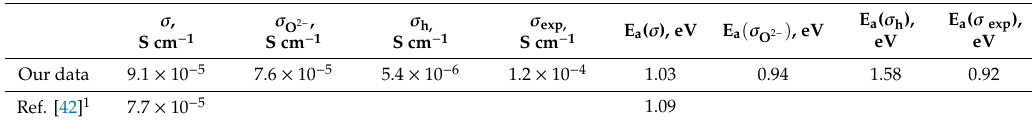
Table 1. The calculated values of the total, oxygen–ion and hole conductivity and the measured total conductivity of bulk SZY at 550 ◦ C in humid air ( p H 2 O = 3365 Pa) and the corresponding activation energies.